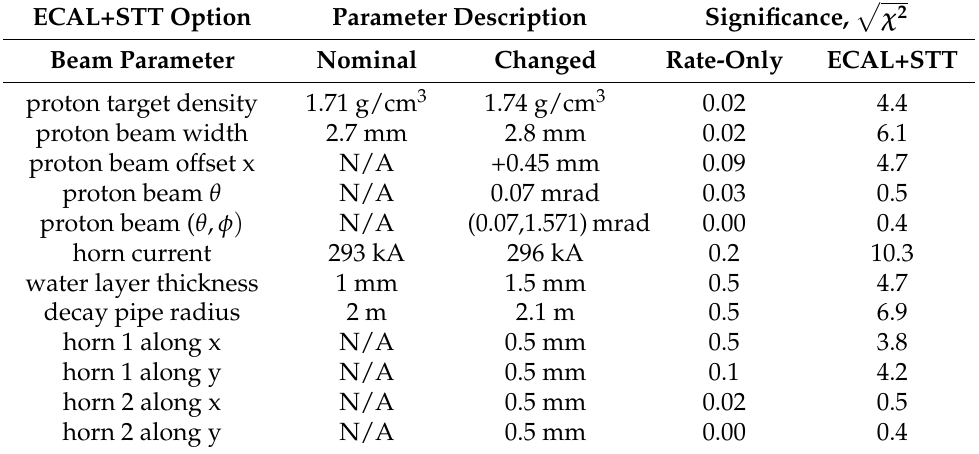
Figure 136. Values of ∆ χ 2 as a function of applied shift on the location of the beam axis along the X direction for the STT-only detector configuration. The independent sample from the upstream barrel ECAL and the STT fiducial volume are combined. The results obtained with three different methods are compared: X distribution (magenta curve), single E ν distribution (blue curve), and two separate E ν distributions for events with X < 0 and X > 0 (red curve). The horizontal line corresponds to a significance ∆ χ 2 = 9. See text for details. Table 19. The beam parameter description as well as the significance for the observation of a change in the beamline are shown for the STT-only configuration. The significances are computed by using the neutrino spectral information, by assuming 7-days of data taking and by considering neutrino interactions occurring in both the upstream barrel ECAL and within the STT. A complete detector simulation taking into account the fine-grained structure of the electromagnetic calorimeter was implemented and the GENIE 2.12 and edep-sim with GEANT4 v4.10 were used to simulate the neutrino interaction and final state particle energy deposit in the detector system. In addition equivalent FLUKA simulations were performed as well, for a validation of the results at lower energy. A hit-based detector smearing was used for reconstructing the neutrino energy, taking into account the contributions from the muon and the hadrons. The corresponding values for the “Rate-only” detector as in Table 18 are also given for comparison. This work is further described in